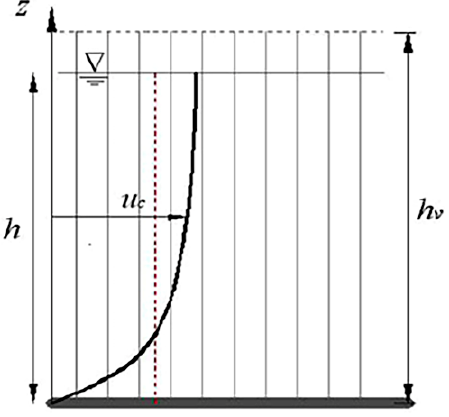
Figure 2. Flow over unsubmerged rigid vegetation.